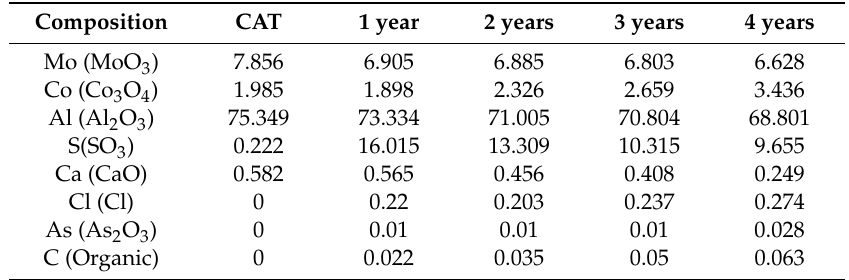
Table 2. Elemental distributions of di ff erent CATs (fresh–used), the standard deviation of the measured value is set as unity in the last decimal.